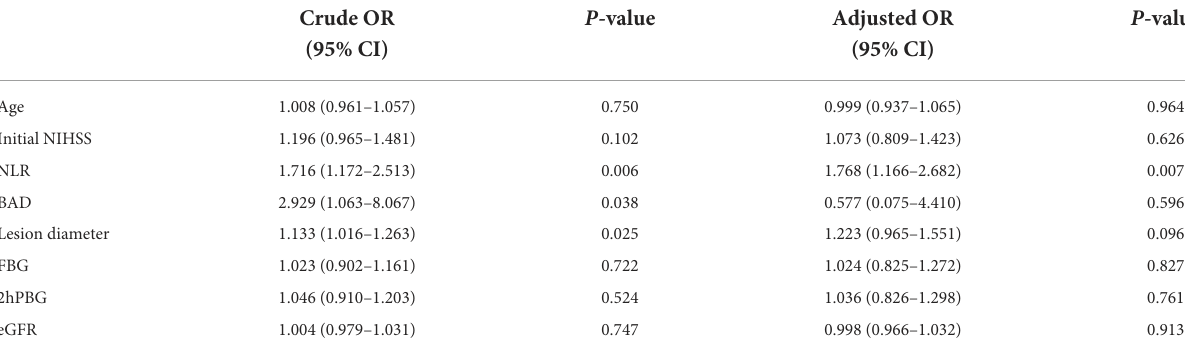
TABLE 3 Logistic regression analysis of the factors associated with END in SSI patients with diabetes.